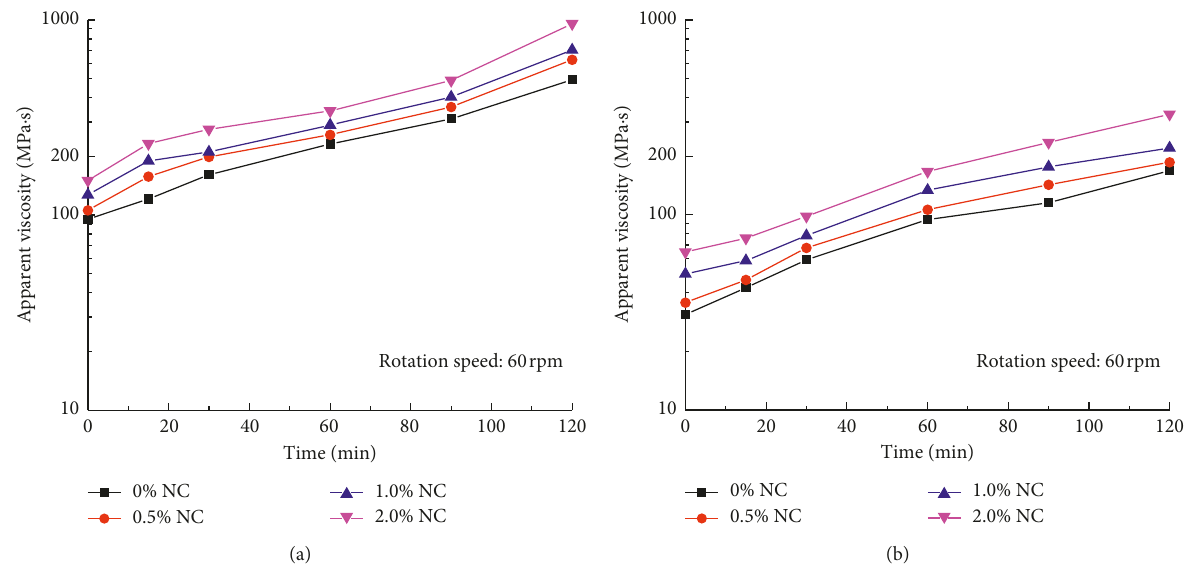
Figure 2: Apparent viscosity of grouts with different NC contents: (a) 0% SP; (b) 1.5% SP.